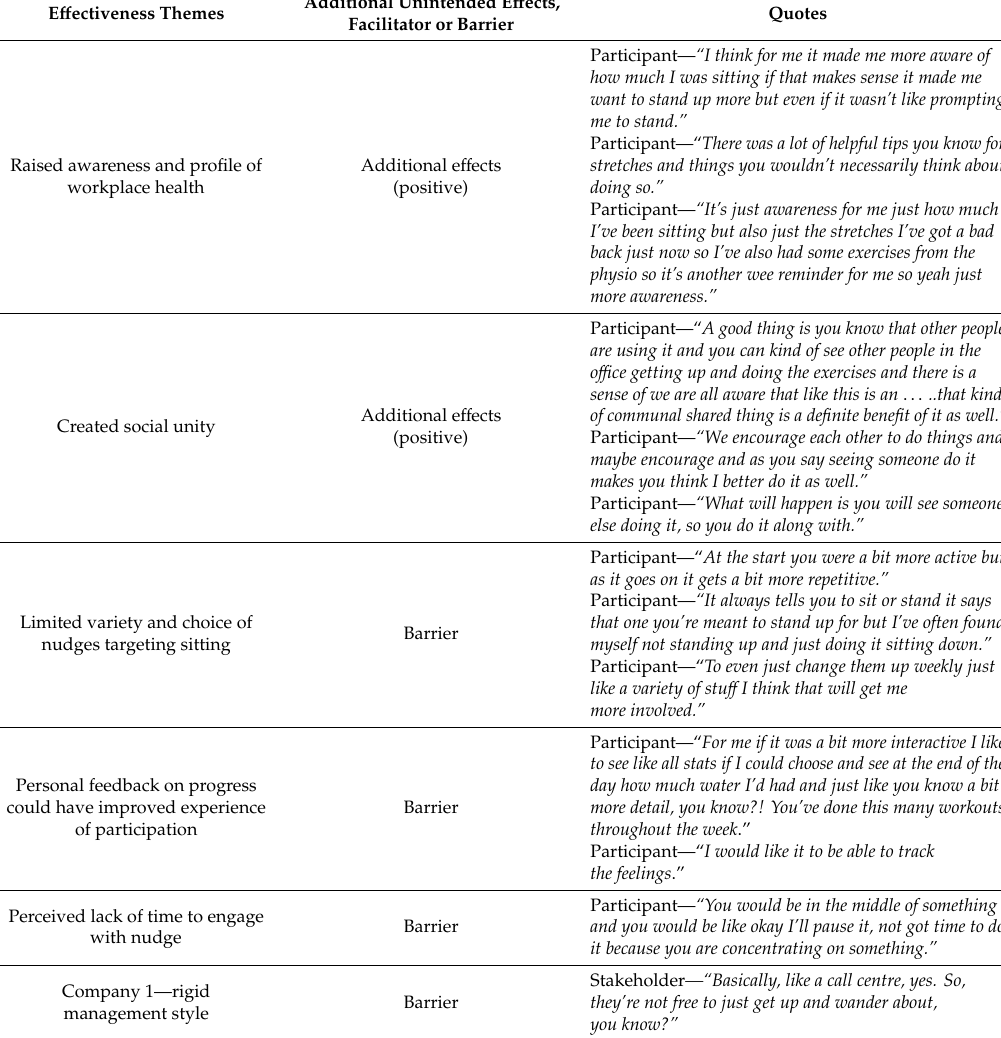
Table 10. Qualitative themes related to indicators of e ff